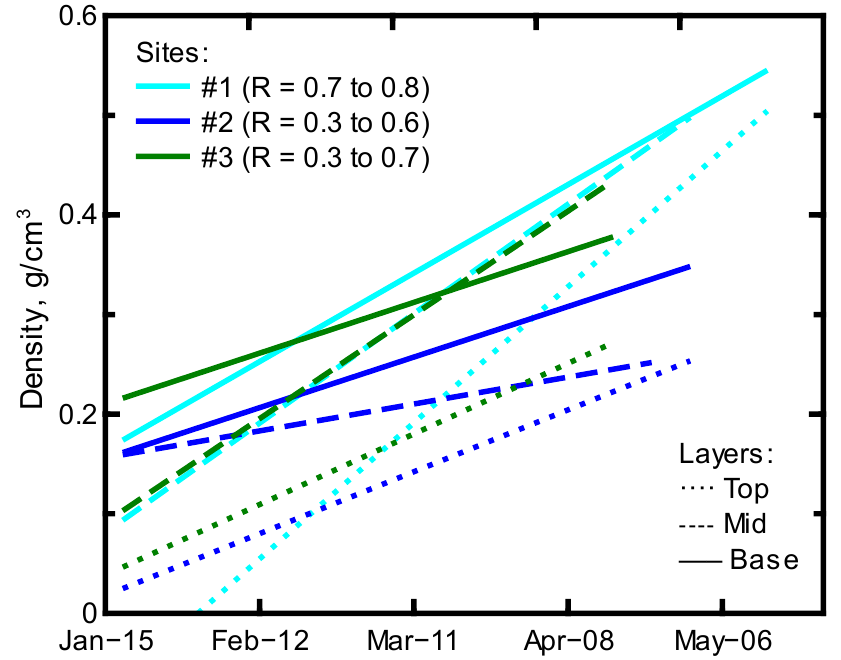
Figure 6. Linear regression trendlines of the density data collected for each layer at the three study sites.